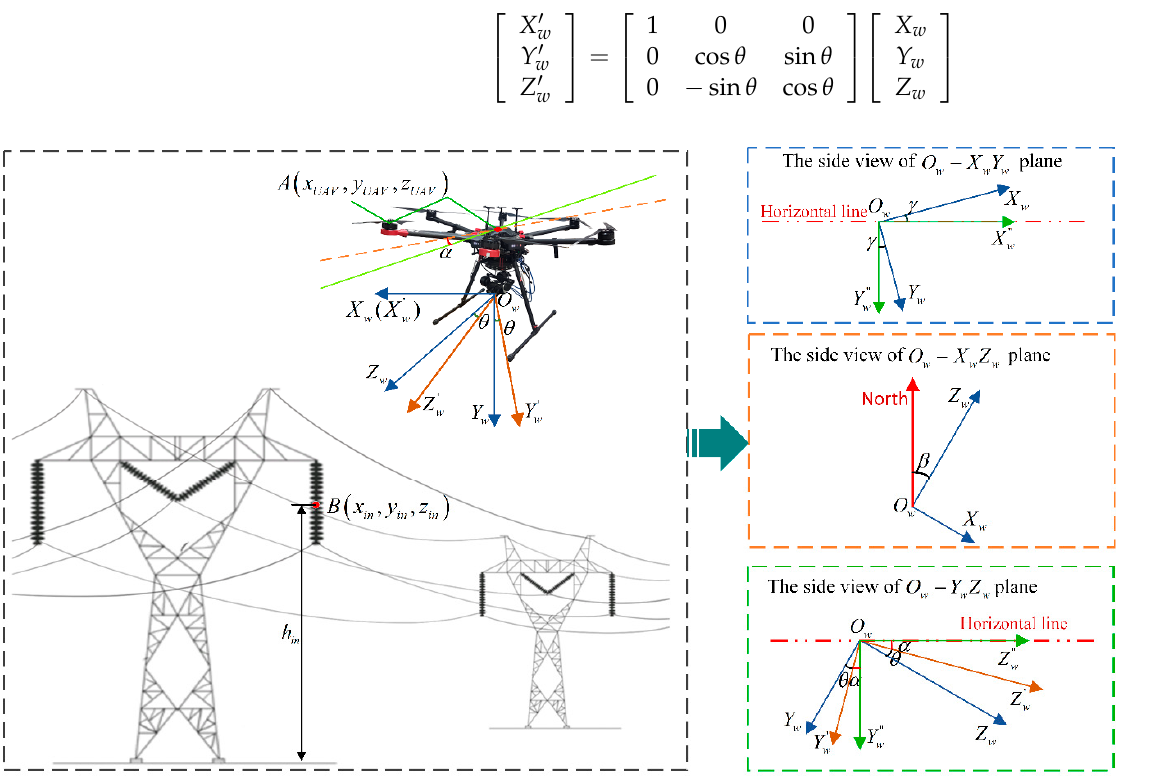
Figure 8. Schematic diagram of spatial positioning method of insulator combining binocular stereo vision with unmanned aerial vehicle (UAV)’s GPS.